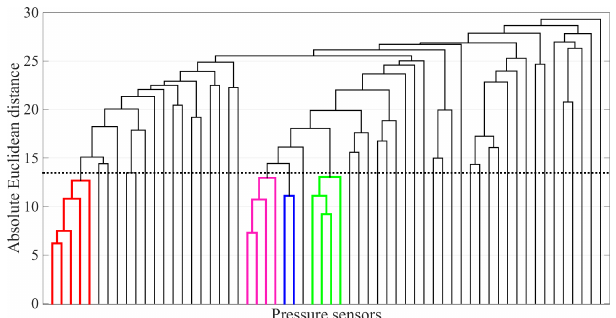
Figure 4. Example of a dendrogram computed by agglomerative hi- erarchical clustering over the 60 time series presented in panel (a) of Fig. 3. The coloured lines correspond to the four clusters shown in panels (b) – (e) of Fig. 3. The thick dotted line corresponds to a split point (SP) that would output the same four identified clusters. Diur- nal residuals are normalized by their standard deviation; therefore, their values and Euclidean distances are dimensionless